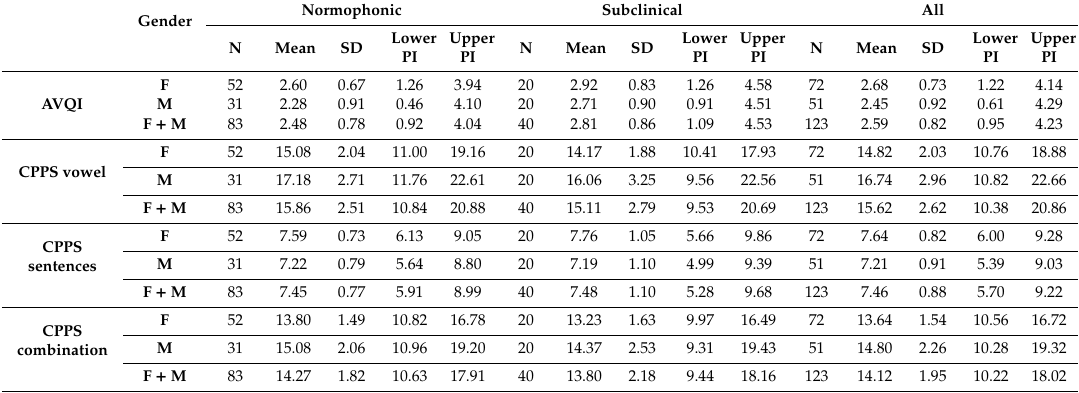
Table 2. Descriptive norm-referencing data of AVQI and CPPS. PI: prediction interval, SD: standard deviation.